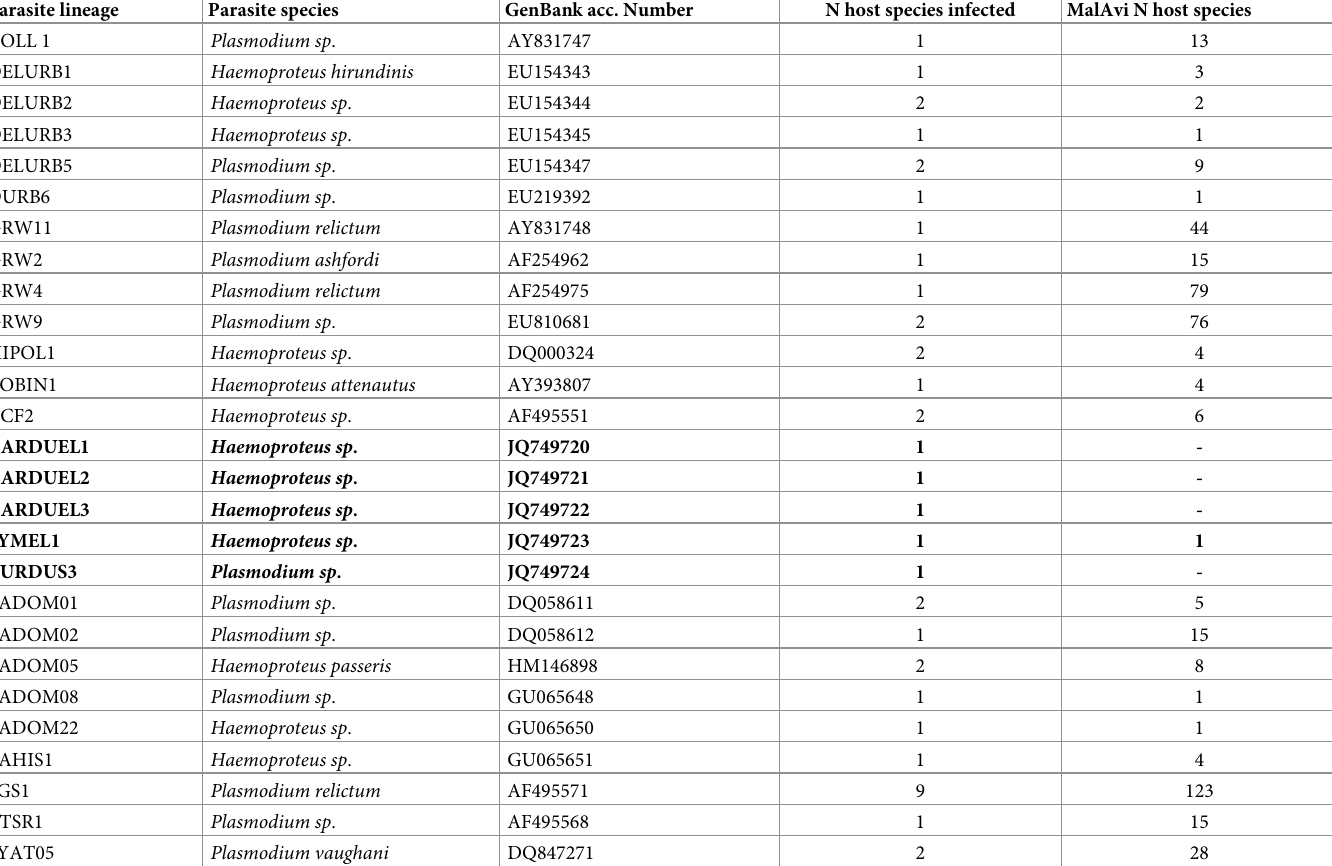
Table 2. Cytochrome b parasite lineage, tentative parasite species names, GenBank accession numbers and the number of host species infected by parasite lineage in the current